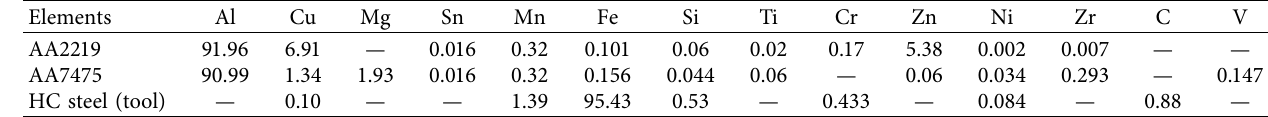
Table 1: AA7475, AA2219, and HC steel: chemical properties (wt. %). Elements